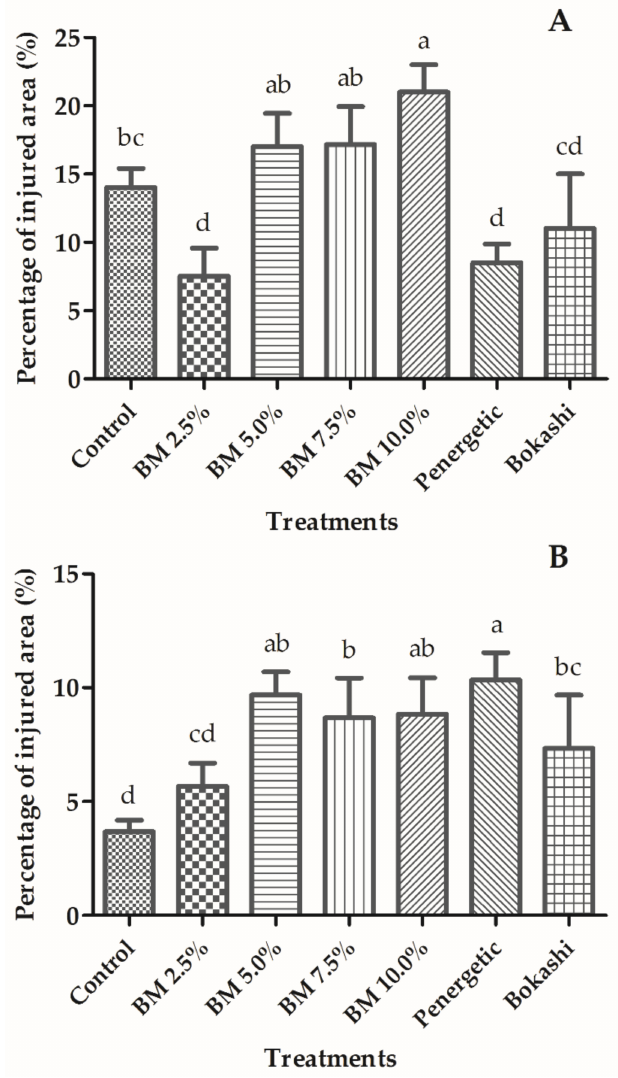
Figure 1. Area under the disease progress curve (AUDPC) of powdery mildew (Leveillula taurica L é v. G. Arnaud) on tomato plants fertilized with boiled manure (BM), Penergetic, or Bokashi. ( A ): First cycle; ( B ): Second cycle. Londrina, Brazil 2015 and 2016. Bars are means ± SD, and are not significantly different if they have the same letter based on Tukey’s test ( p >